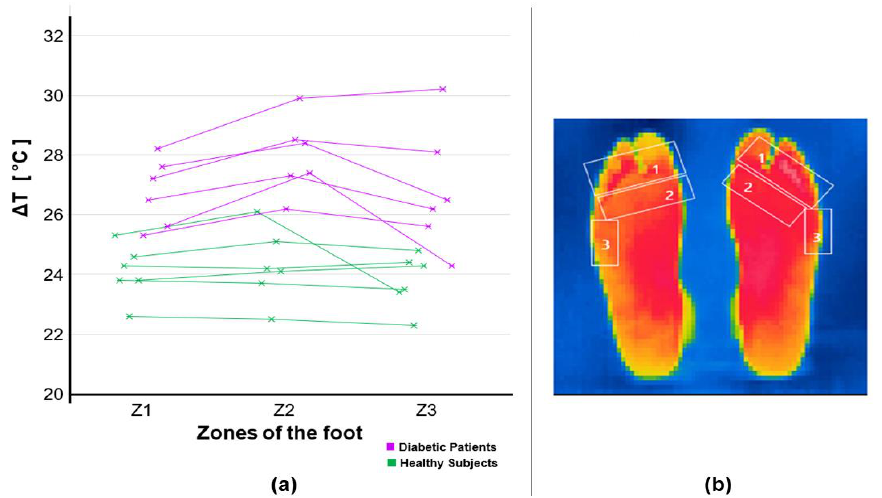
Figure 9. ( a ) Comparison of temperatures by zone of the sole of the foot; the purple line corresponds to the temperatures of diabetic feet and the green line to healthy subjects. ( b ) Areas selected for the temperature study.